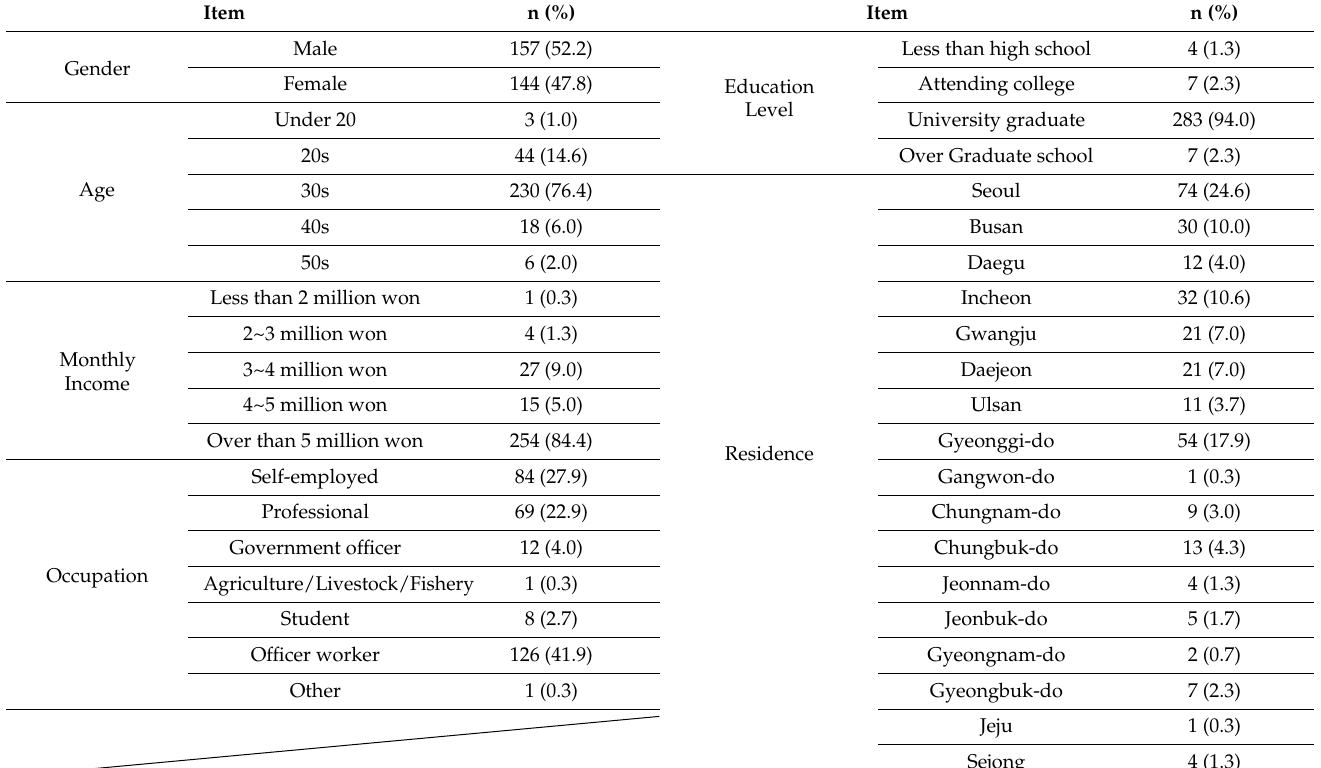
Table 1. Demographic characteristics of